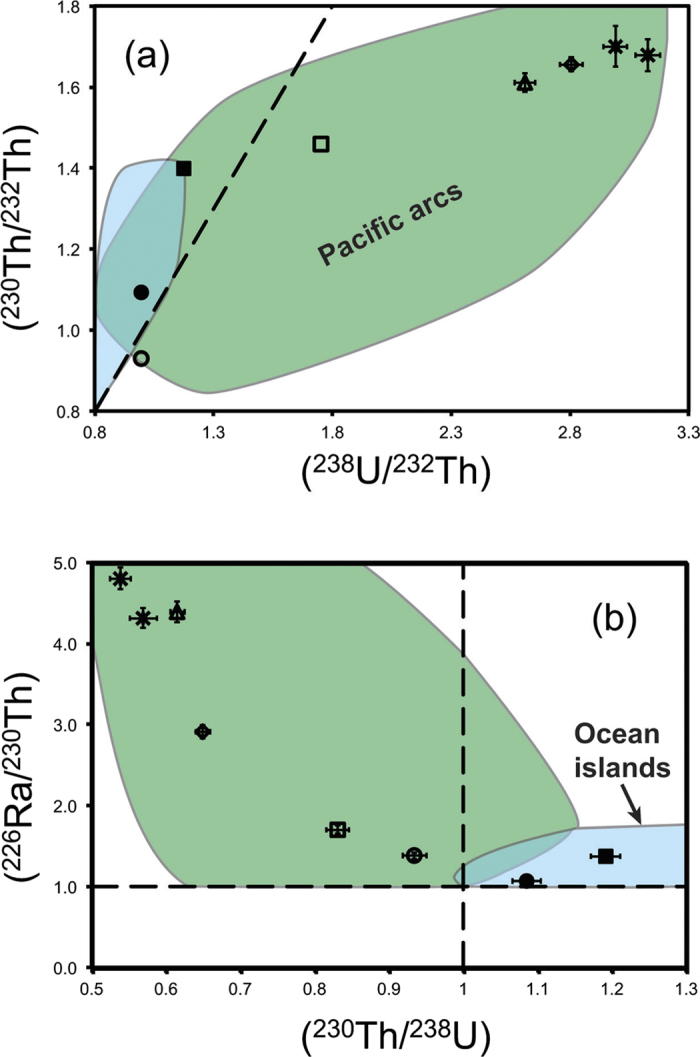
Plots of (a) (230Th/232Th) versus (238U/232Th) and (b) (226Ra/230Th) versus (230Th/238U) for samples listed in Table 2 from island arcs and ocean islands.The blue and green fields in (a) and (b) mark the range of ocean island basalts and western Pacific island arcs respectively21215293233343536 for comparison. Dashed lines denote secular equilibrium. Symbols as in Fig. 1. Error bars are illustrated for values larger than the sample symbols.